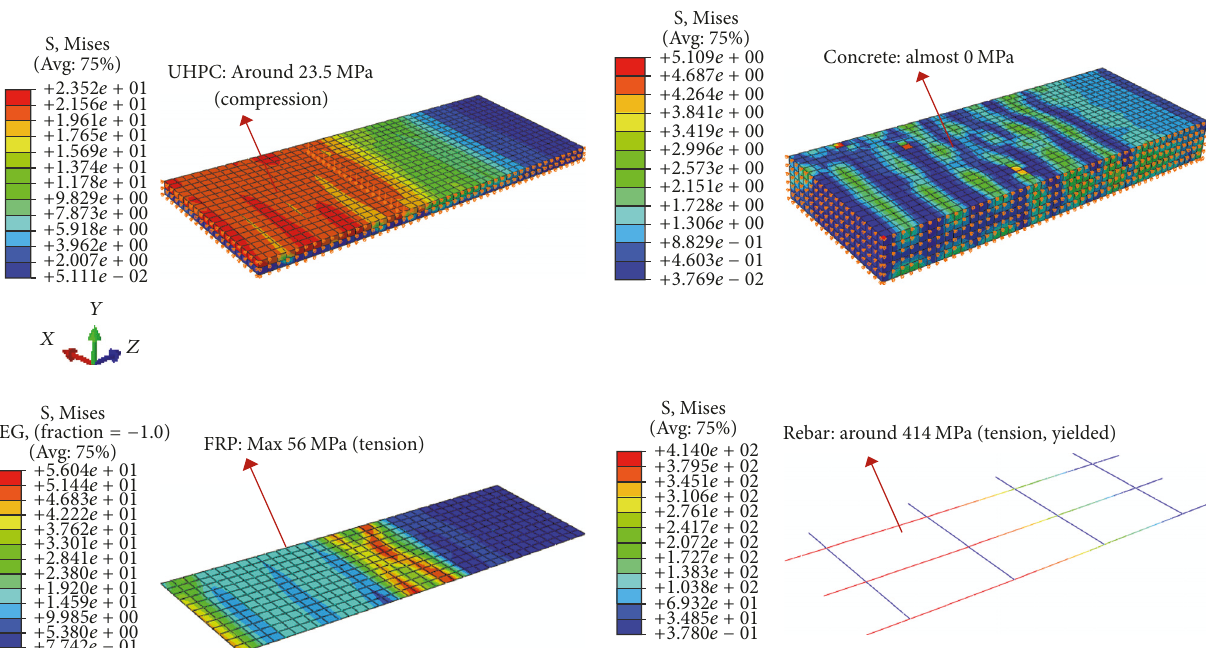
Figure 11: Stresses in HPC overlay at yield